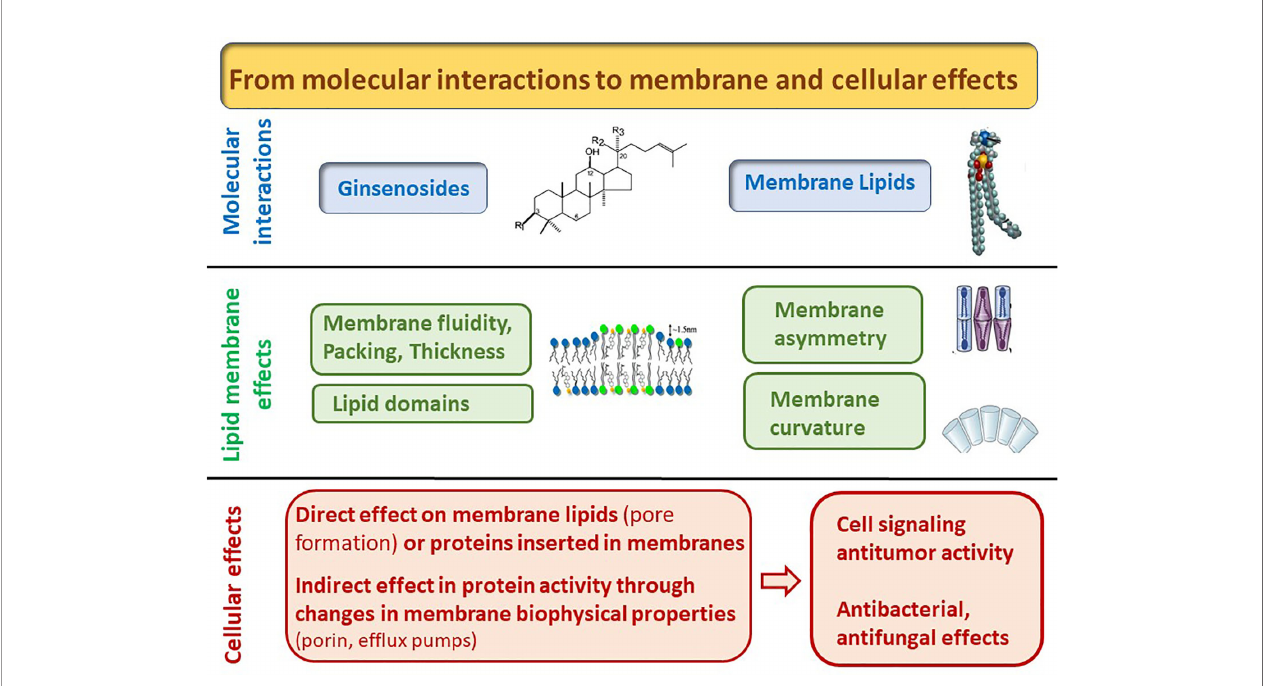
FIGURE 2 | From molecular to cellular and biological effects induced by the interaction of ginsenosides with